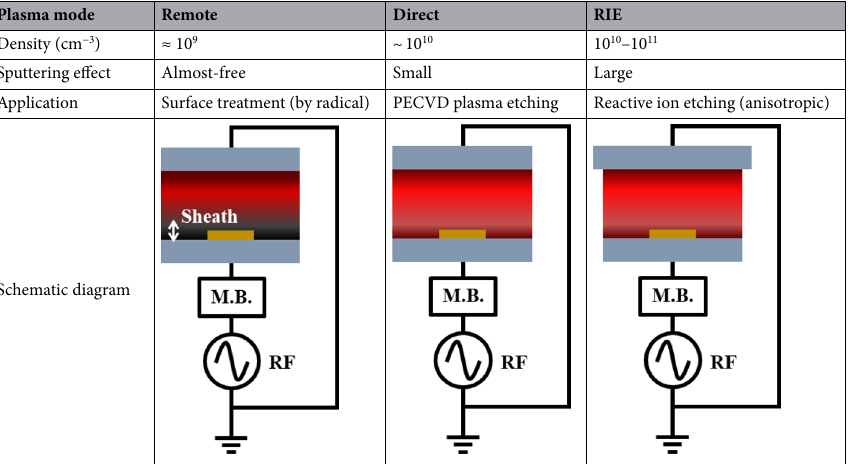
Table 3. Plasma properties of each plasma mode.